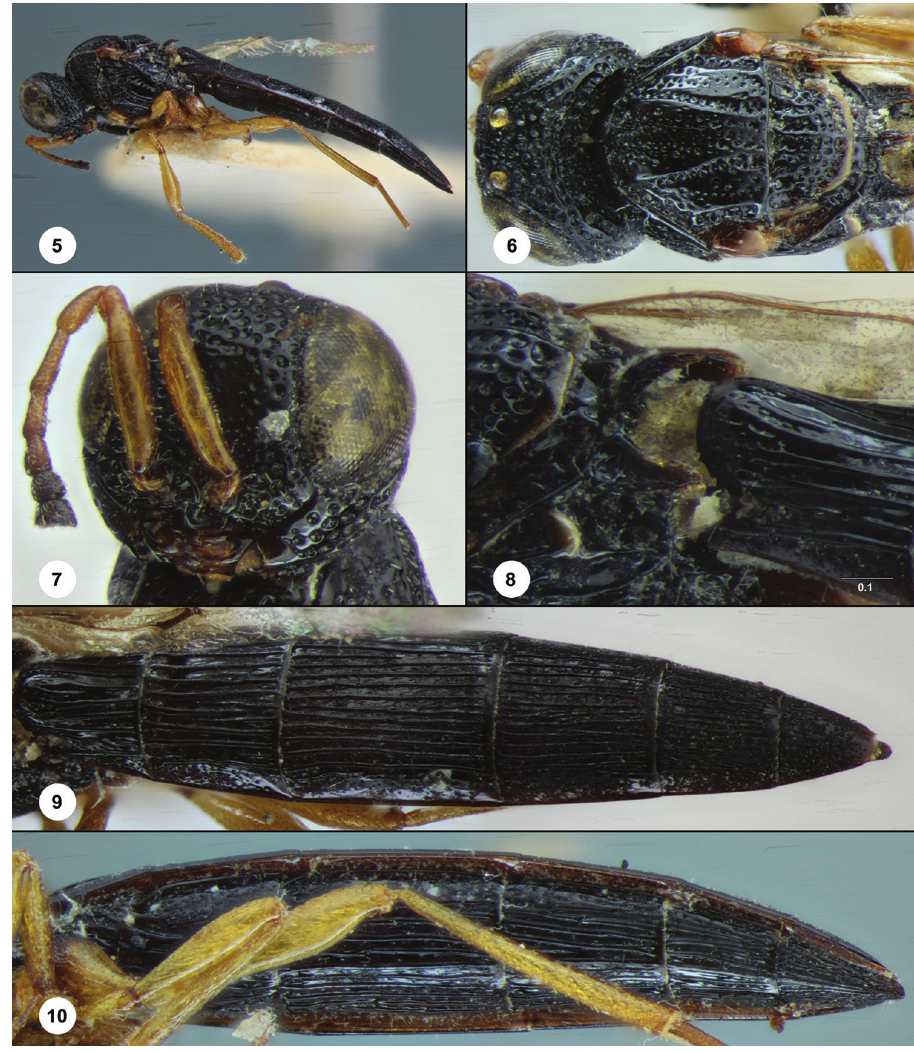
Figures 5–10. Habroteleia dagavia , female holotype (IEBR 0143). 5 head, mesosoma, metasoma, lateral view 6 head and mesosoma, dorsal view 7 head, anterior view 8 mesoscutellum, metascutellum, propodeum, T1, dorsolateral view 9 metasoma, dorsal view 10 metasoma, ventrolateral view. Scale bars in millimeters.